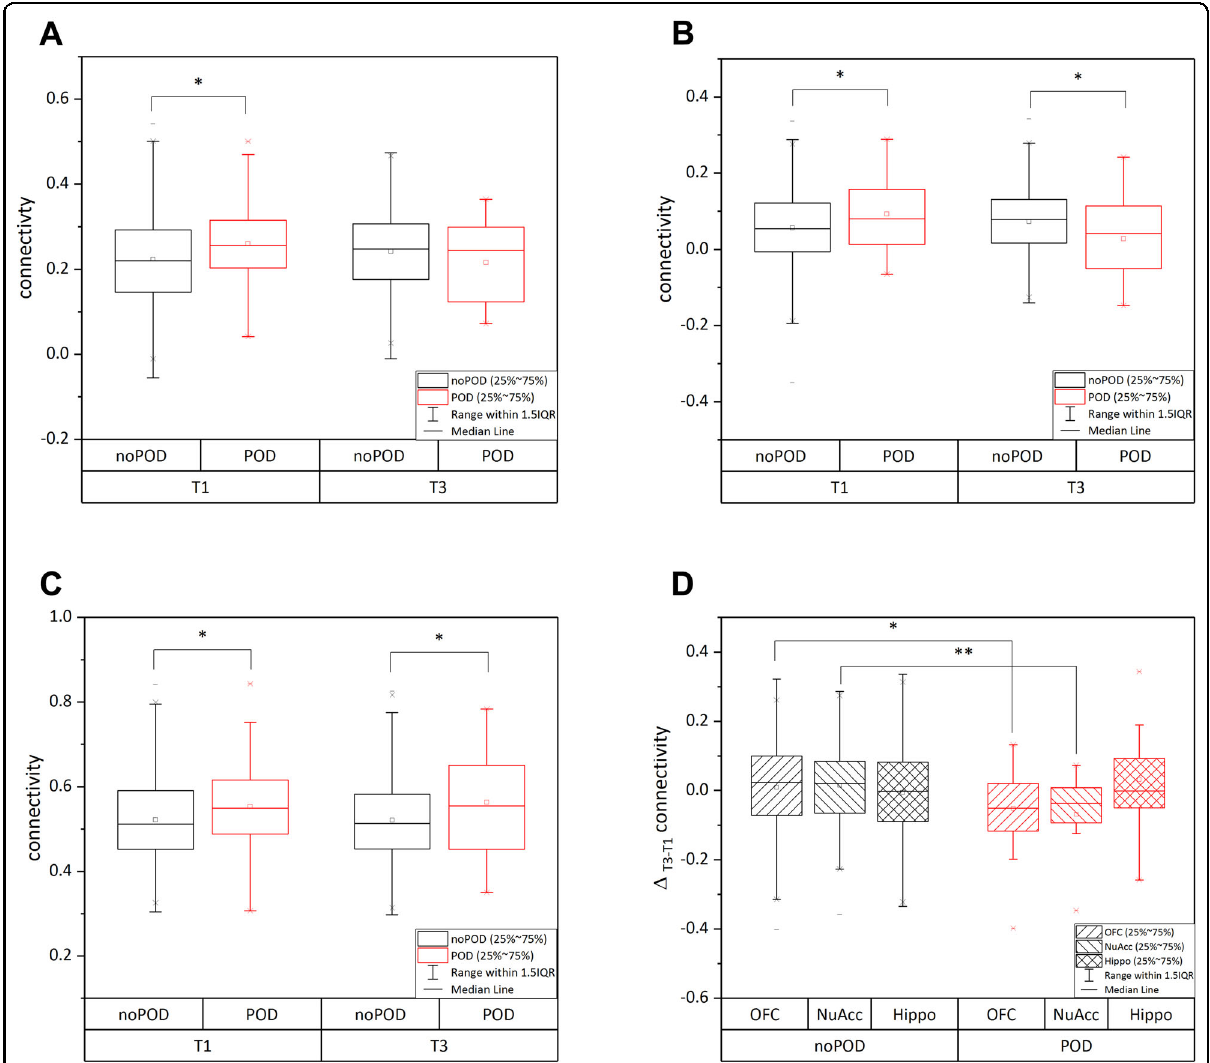
Fig. 3 Pre-/post-operative scores (T1 – T3). A Orbitofrontal cortex network: Right inferior frontal triangulate gyrus. B Nucleus accumbens network: Right planum polare. C Hippocampus network: Right hippocampus. D Signi fi cant course connectivities between no-POD and POD. Note: * p < 0.05. POD postoperative